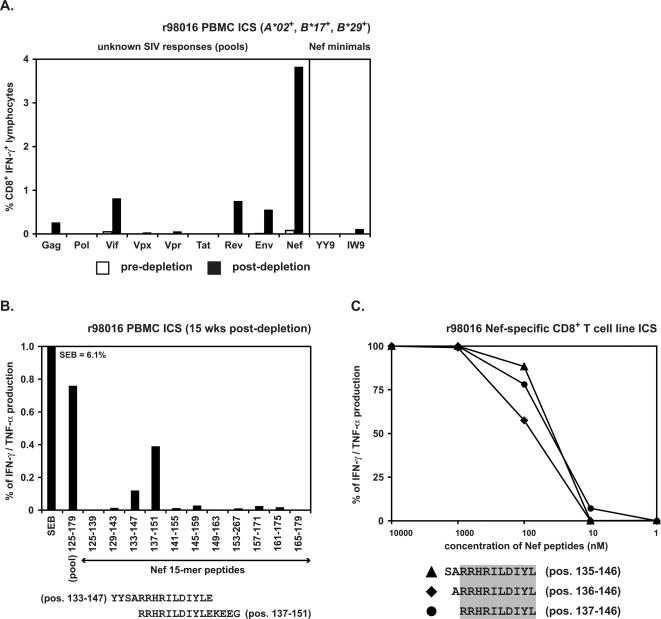
Identification and mapping of a novel CD8+ response directed against Nef that expanded in the CD8+ cell-depleted EC macaque r98016.MHC class I alleles detected by PCR-SSP are listed for r98016. A) Unknown CD8+ responses from ex vivo ICS assays using SIV peptide pools performed one month prior to (white bars) and four weeks after (black bars) CD8+ cell depletion. Responses to 15-mer pools that did not contain previously identified minimal optimal epitope sequences [i.e., Nef159–167YY9 and Nef165–173IW9] [64], [73], [82] are summed for each protein. Of particular interest was an unknown SIV-specific CD8+ response directed against Nef, which expanded in Mamu-B*17-positive EC r98016. B) Ex vivo ICS deconvolution of peptide pool Nef D (positions 125–179) using r98016 PBMC revealed that the novel CD8+ epitope was located within two overlapping 15-mers in Nef (positions 133–151). C) ICS results using peptide dilutions with a Nef-specific CD8+ T cell line from r98016 fine-mapped the novel CD8+ epitope to a 10-mer at positions 137–146 in Nef (RRHRILDIYL).